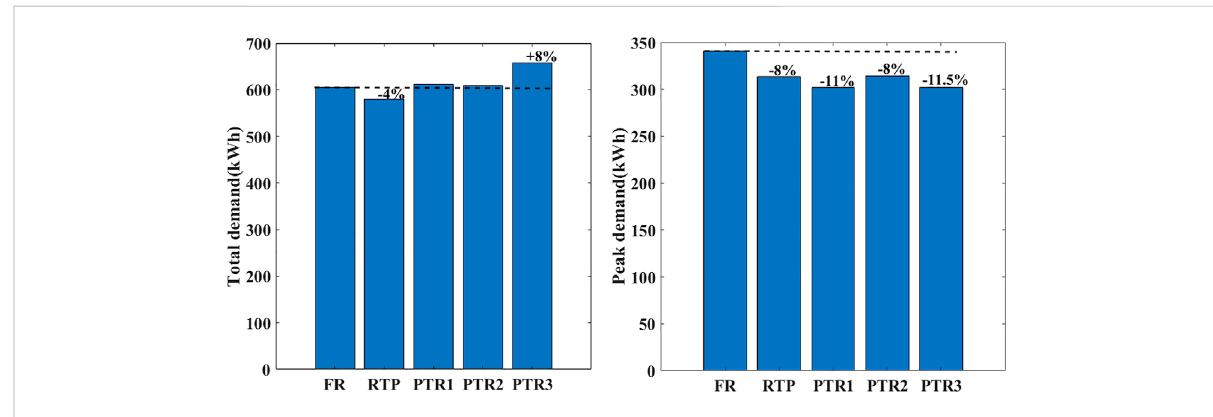
FIGURE 14 Total demand and peak demand for the equal loss scenario.